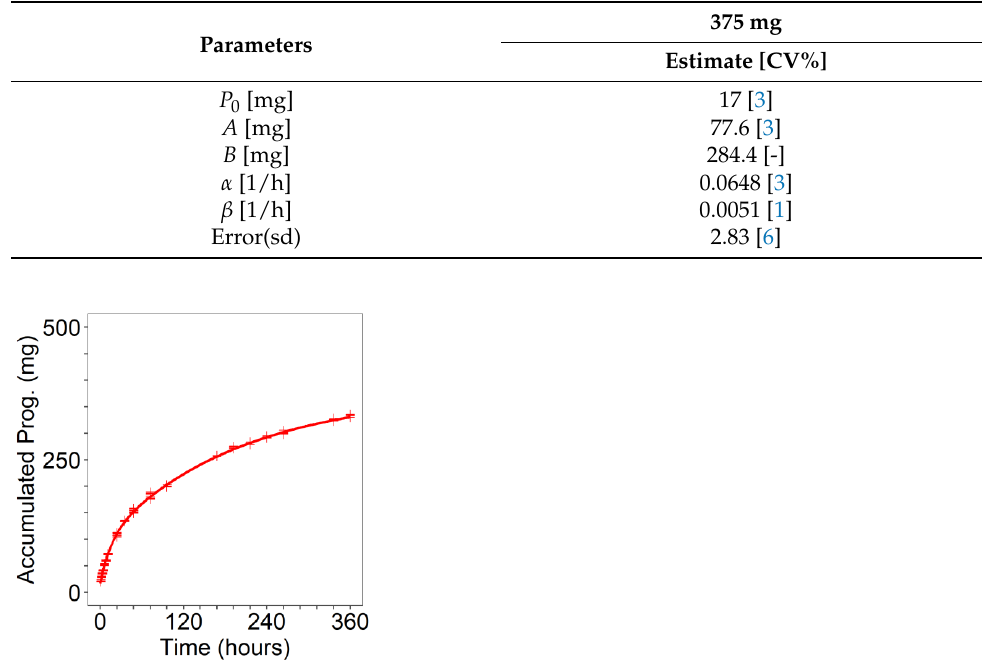
Figure A6. Observed in vitro individual data and fitted cumulative release profiles for test batch (batch E) at 375 mg.